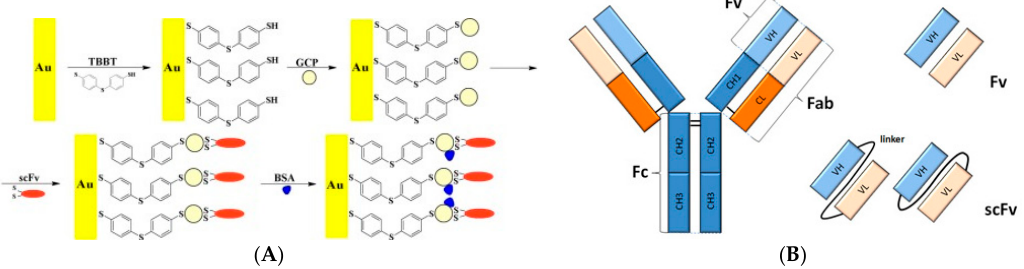
Figure 4. ( A ) Hemagglutinin H5 immunosensor based on a SAM of 4,4 ′ -thiobisbenzenethiol carrying single chain variable fragments (scFv) of antibodies as probes. Reprinted from [31], Copyright 2016, with permission from Elsevier; ( B ) Schematic representation of a scFv fragment. A scFv fragment makes